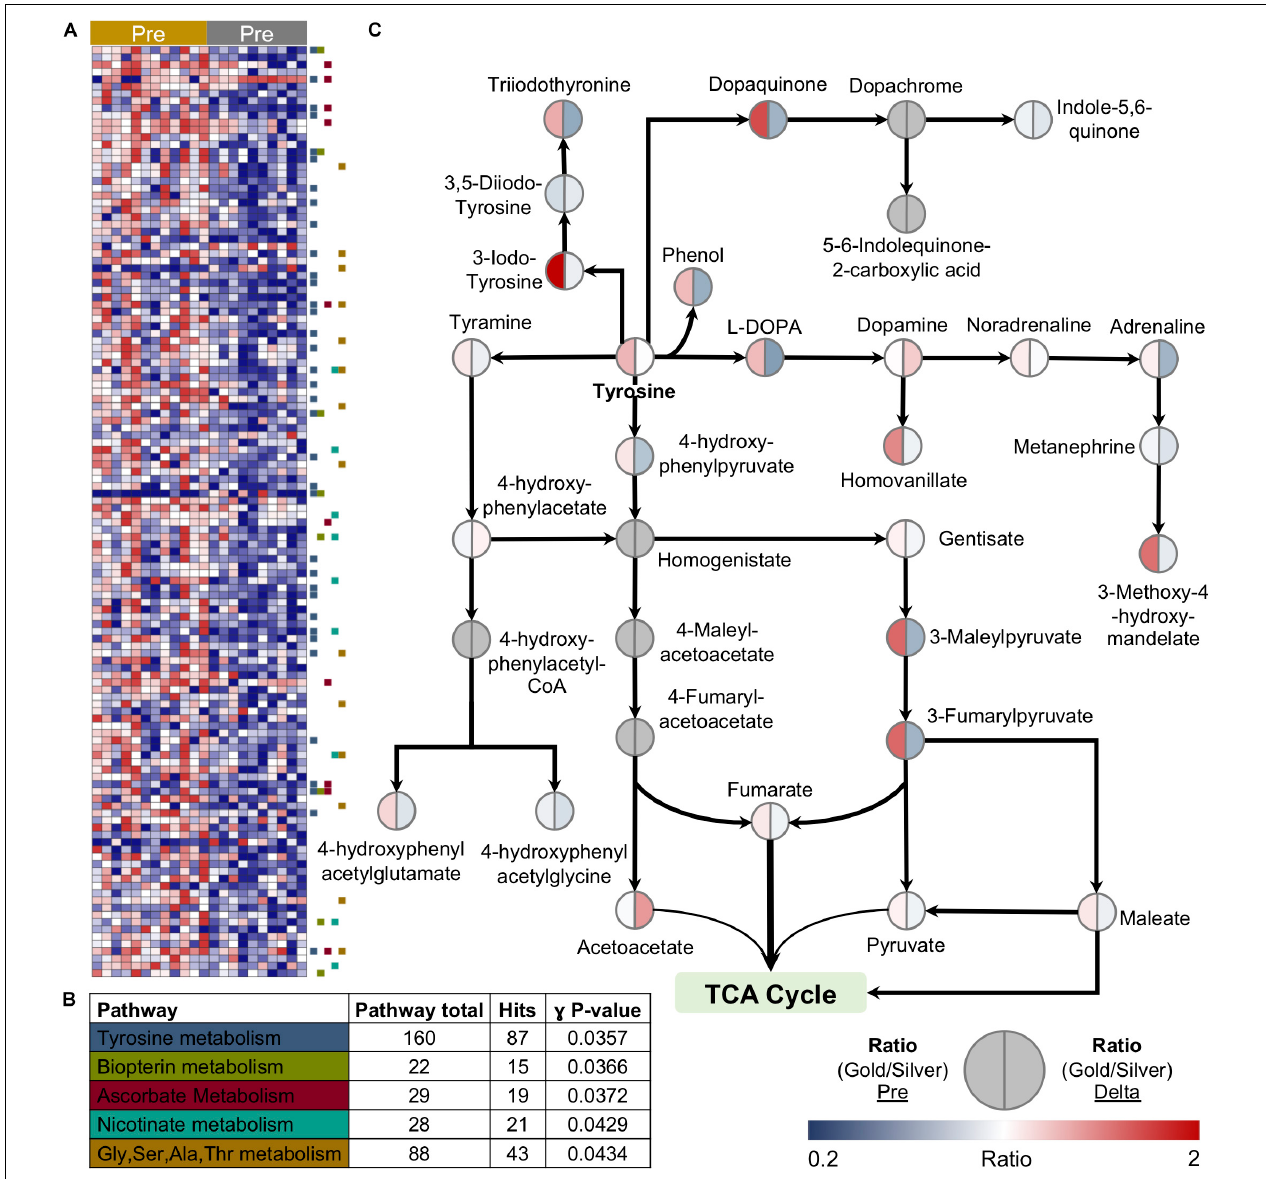
FIGURE 7 | Unbiased metabolomic pathway analysis reveals a link between tyrosine metabolism and lactate levels at performance cutoff. (A) A heatmap of features significantly different between the Gold and Silver groups at baseline is shown. (B) Pathway analysis using the Recon2 model identified the top five pathways enriched in this discovery dataset. (C) Manually validated features within Tyrosine metabolism are shown. The ratio of median values between Gold and Silver groups at baseline is shown on the left side of the circle, while the ratio of the median Delta values (calculated as the Post/Pre fold change) between Gold and Silver groups is shown on the right side of the circle. Values are plotted according to the color scale shown in the lower